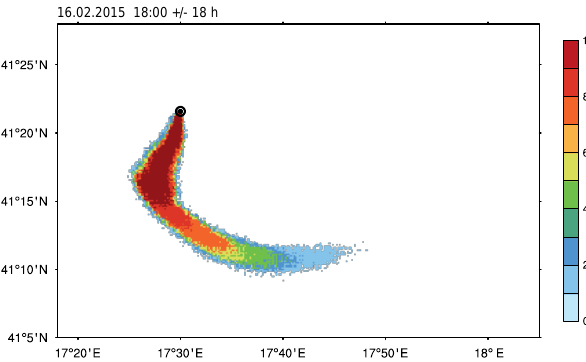
Figure 9. Uncertainty of the oil spill forecast with respect to the starting date of the oil spill (Scenario